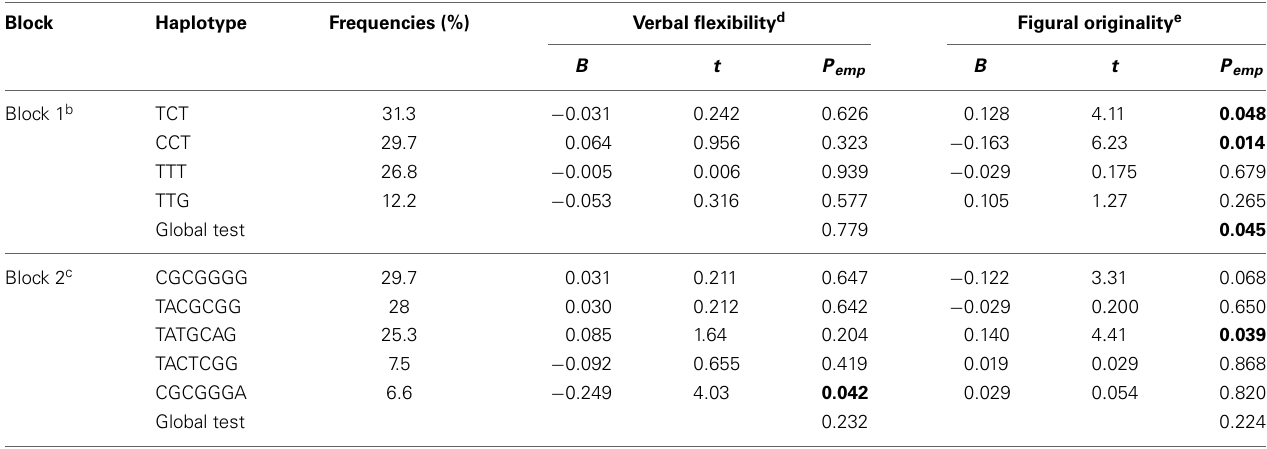
Table 4 | Selected results of haplotype analysis for creative potential a .